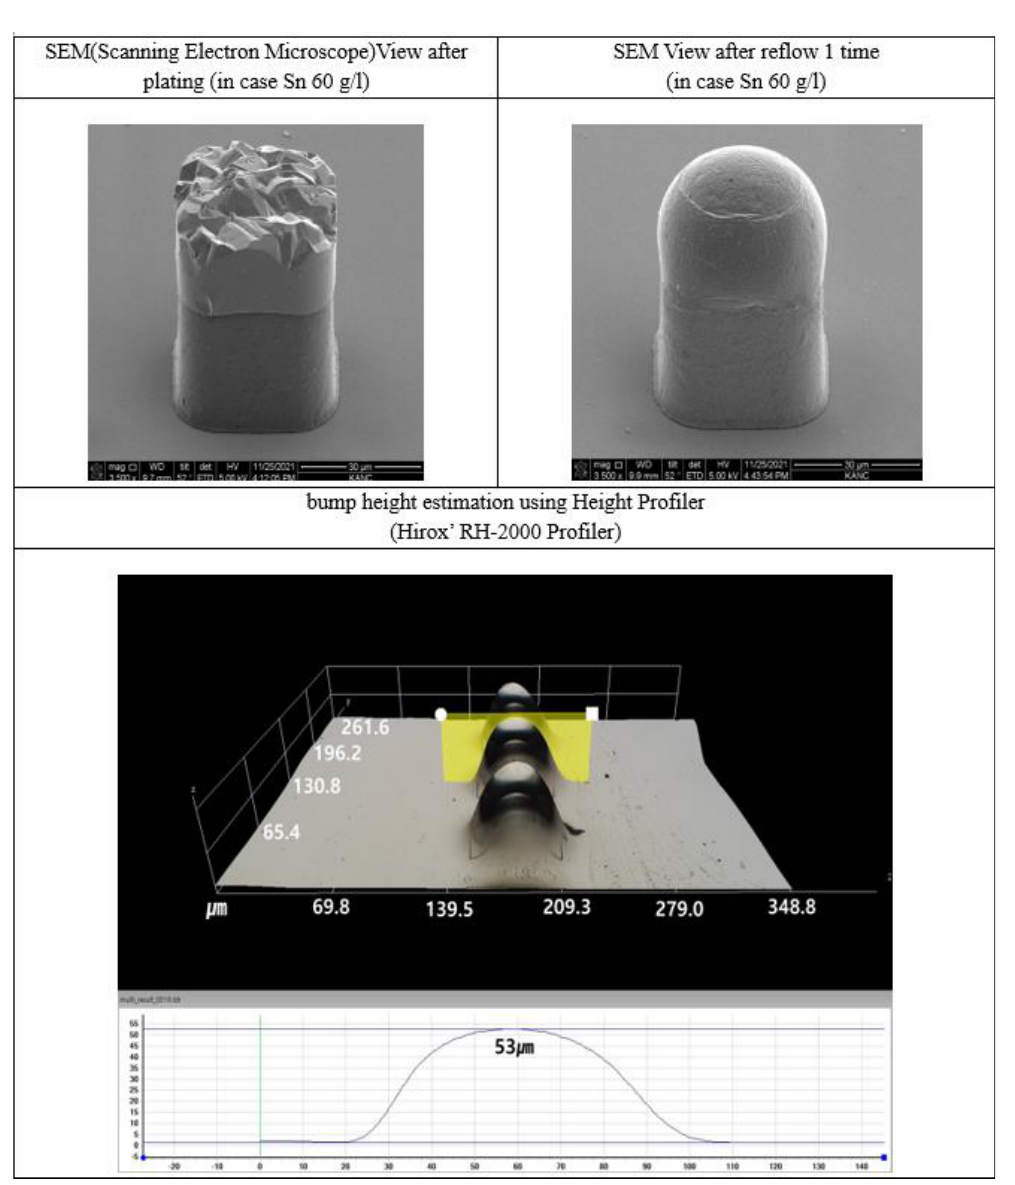
Figure 1. ( a ) Sn Plating System, ( b ) Design, and ( c ) Bump height measurement for Sn Bump Formation.